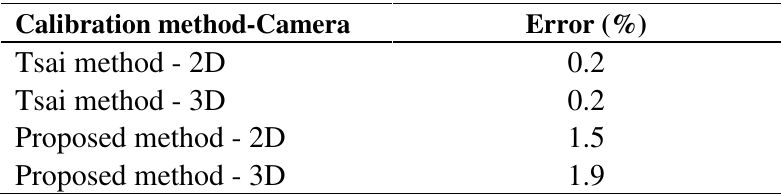
Table 3. Errors for the different calibration methods and cameras.